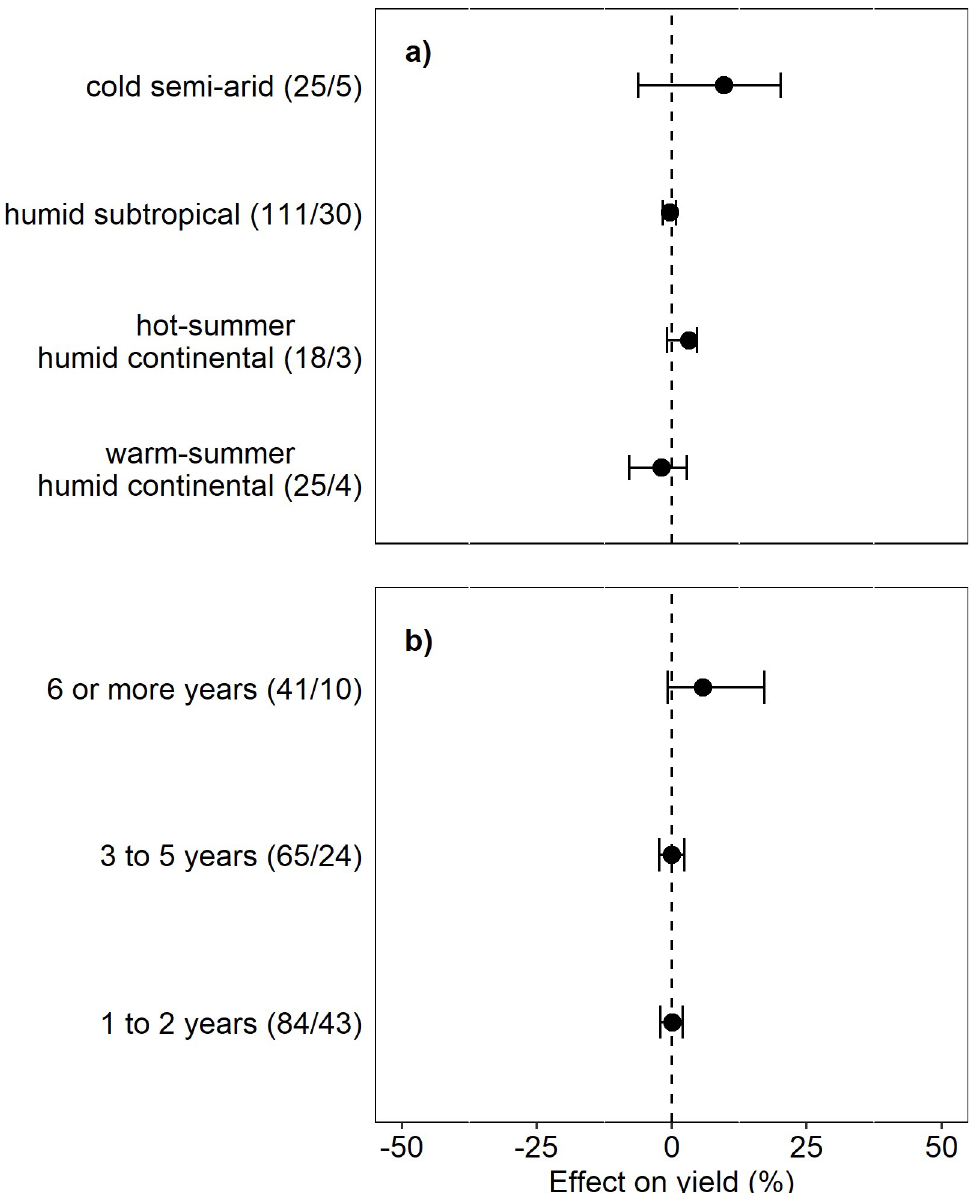
Fig 6. Effect of ICLS on crop yield relative to unintegrated systems within subgroups for (A) climate and (B) length of study. Excludes observations from dual-purpose cropping systems. Climate categories are derived from the Ko¨ppen classification system. Number of observations/number of studies for each category appears in parentheses. Categories with less than 15 observations were omitted from the subgroup analysis. Points represent grazed system yield effect, while the dotted vertical line represents the paired ungrazed system yield. Error bars represent 95% bias-corrected-accelerated bootstrap confidence intervals. Asterisks ( � ) represent a significant yield response in grazed systems relative to ungrazed systems at the 95% confidence